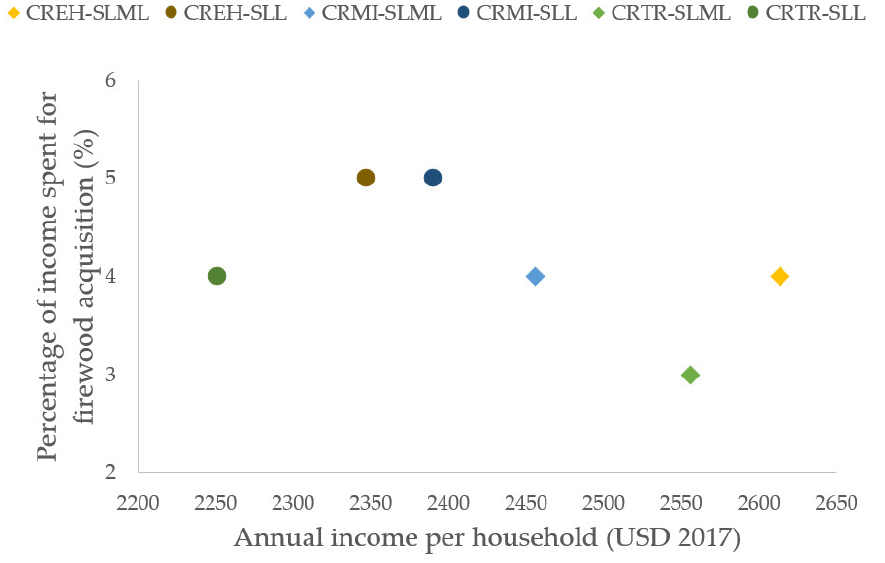
Figure 10. Percentage of household income spent by mixed users of firewood MSU on acquiring firewood by climate region and socioeconomic level. EH, extreme heat; MI, mild; TR, tropical; ML, moderately low; L, low. Source: Own elaboration.